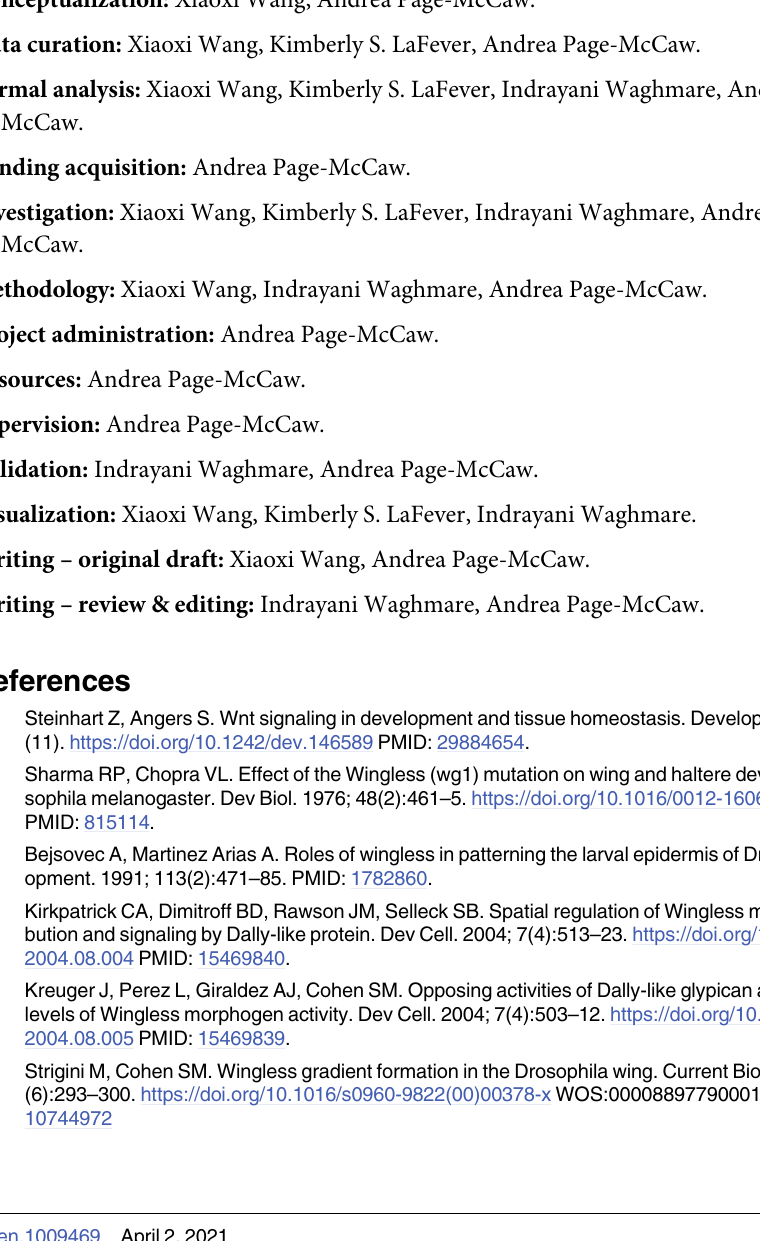
S1 Table. An excel file containing raw data for figure panels 1B-C, 1D, 1E, 3 C-D, and 4H.